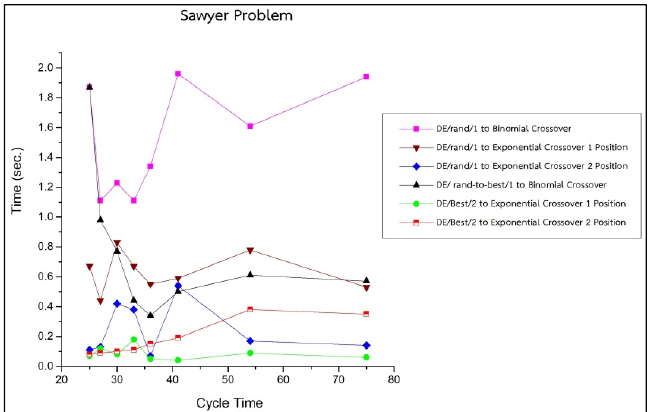
Figure 5. Comparison of Basic and Improved DE Algorithm Using Optimal Solution Search Time with Sawyer Problem.